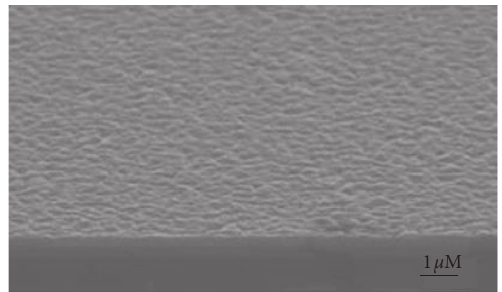
Figure 2: Surface morphology by SEM.